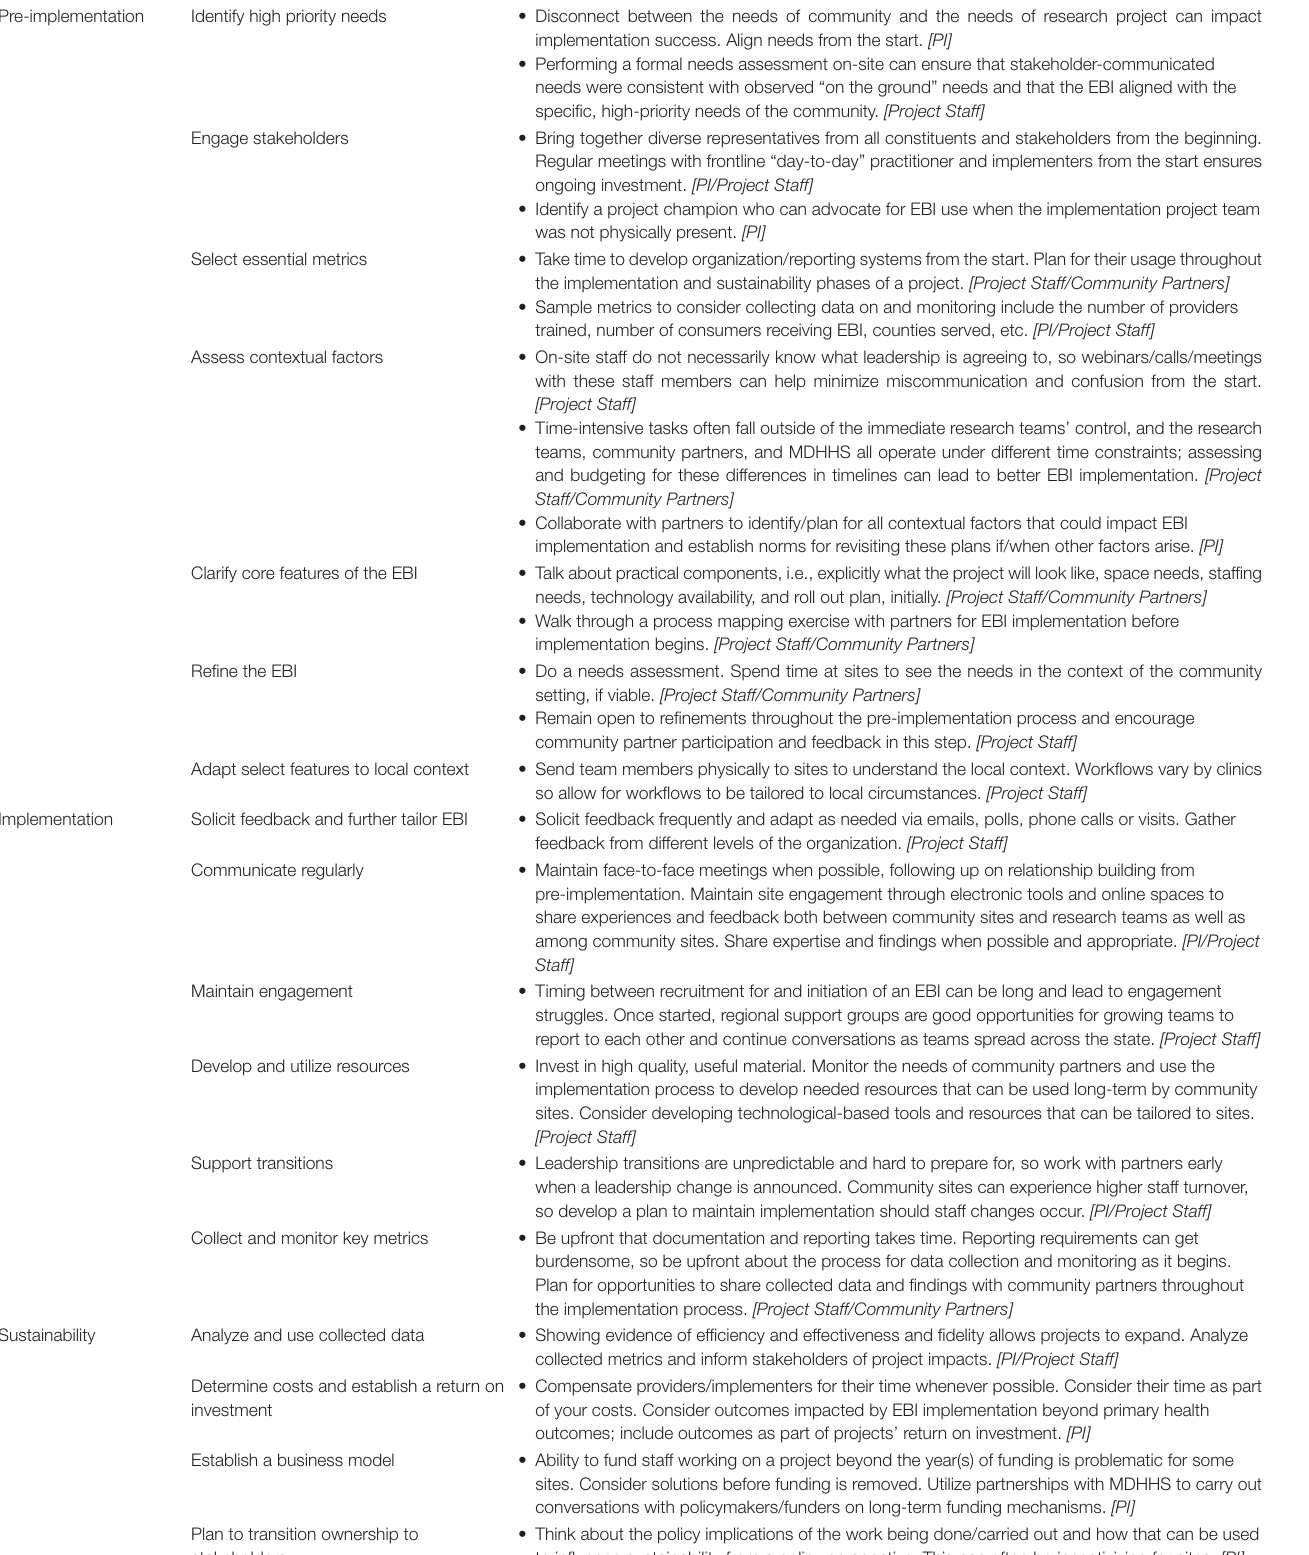
TABLE 3 | Implementation Roadmap components.